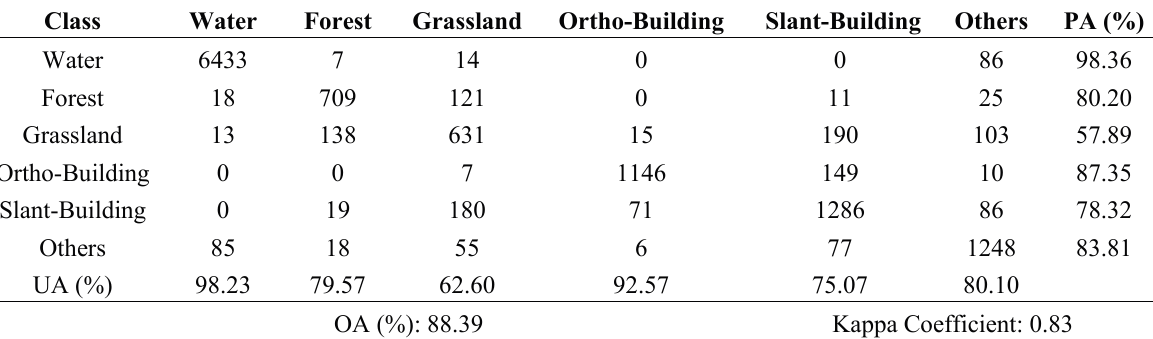
Table 3. Confusion matrix of the proposed classification method. (PA = producer’s accuracy, UA =user’s accuracy, OA =overall